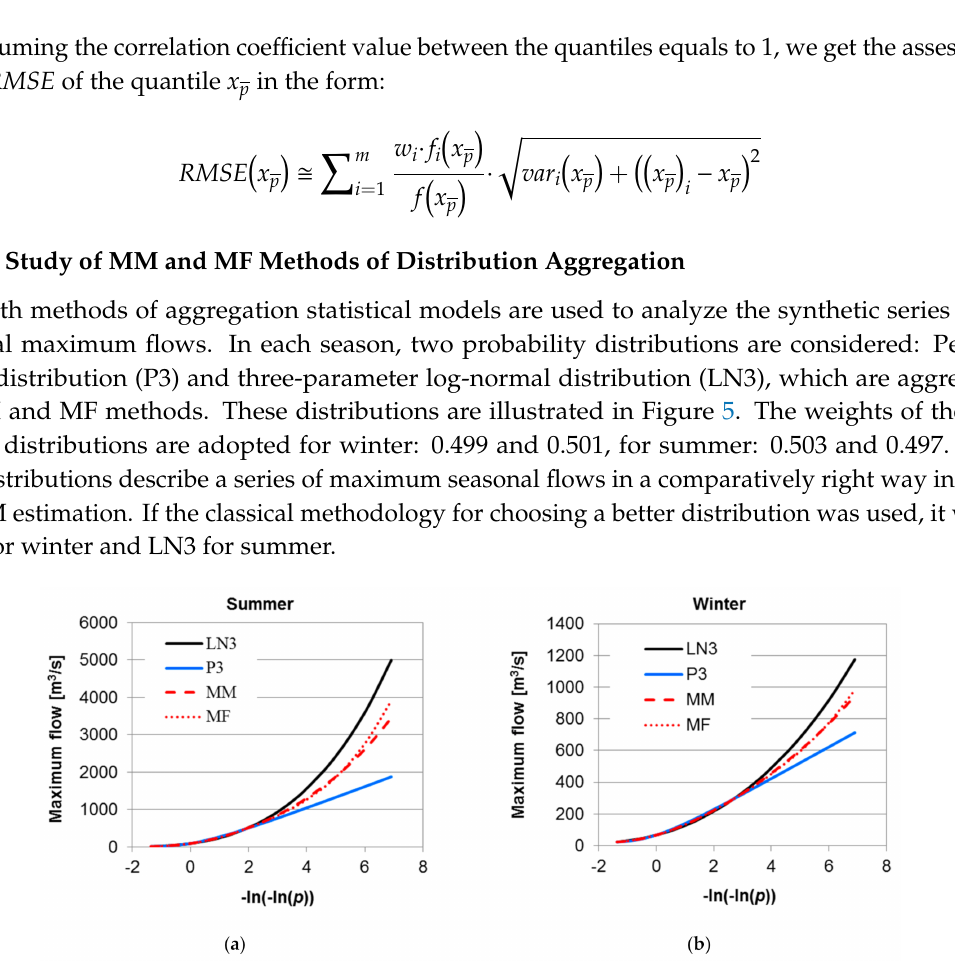
Figure 5. The cumulative distribution functions of maximum seasonal flows along with aggregated models using MM and MF methods: ( a ) in summer; ( b ) in winter.